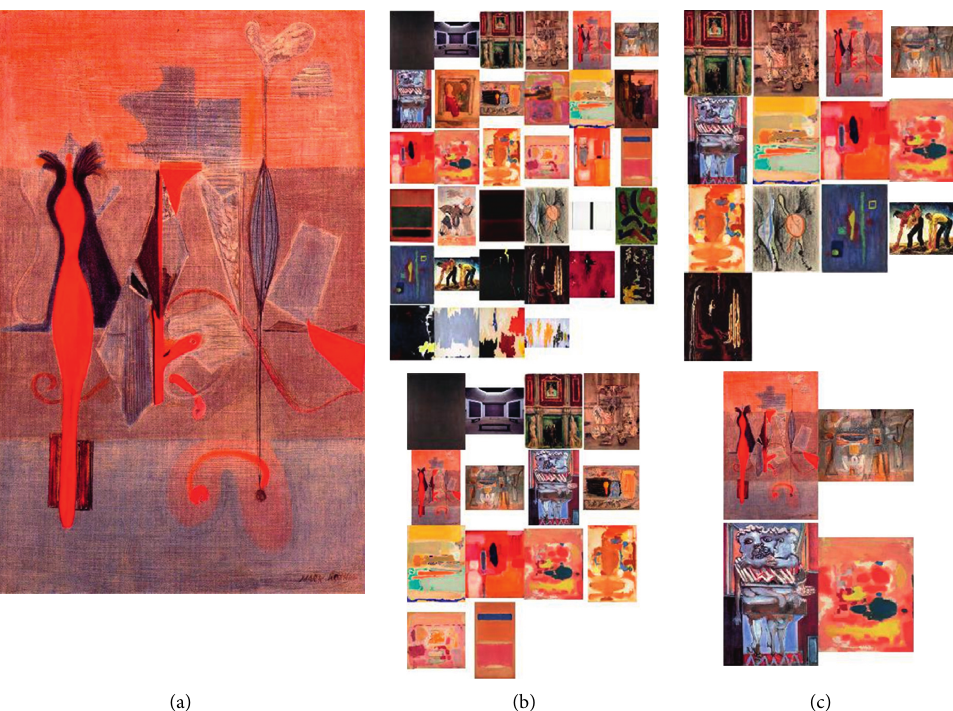
. The first row corresponds 5